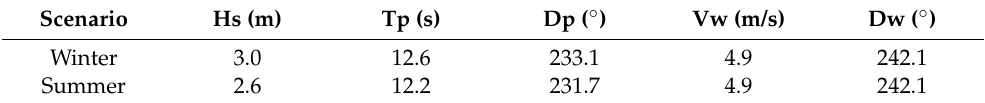
Table 3. Simulation